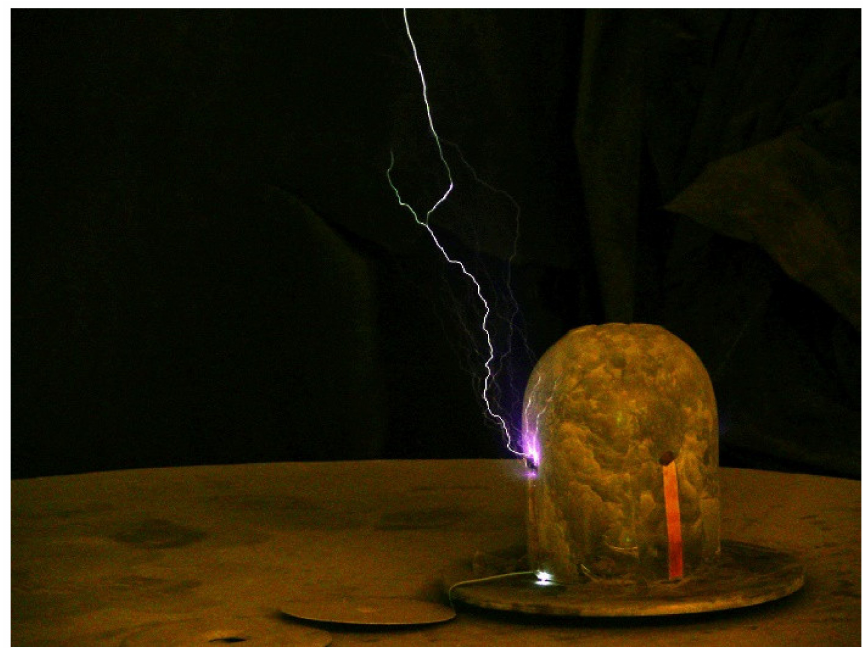
Figure 10. Discharge formation in radome model in the presence of solid stripe electrodes on its outer